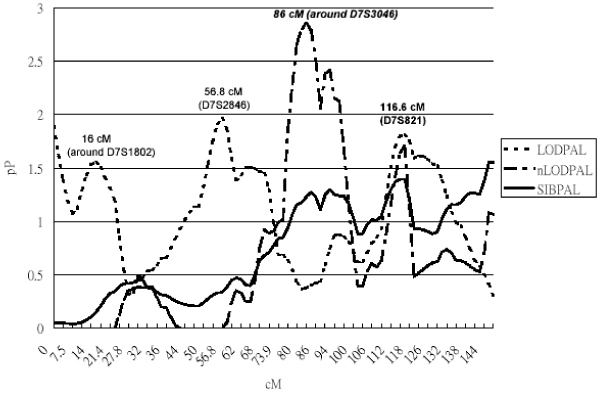
Plots of pP from LODPAL, nLODPAL, and SIBPAL, chromosome 7.